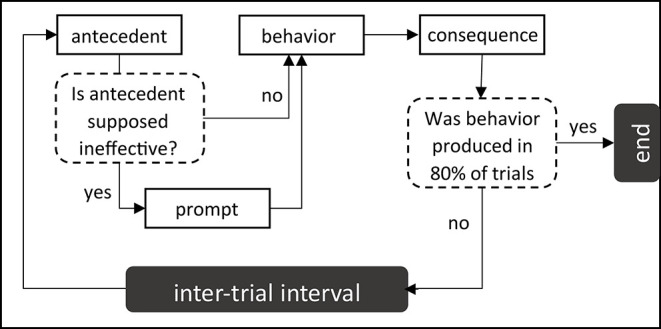
ABA-based procedure of learning.